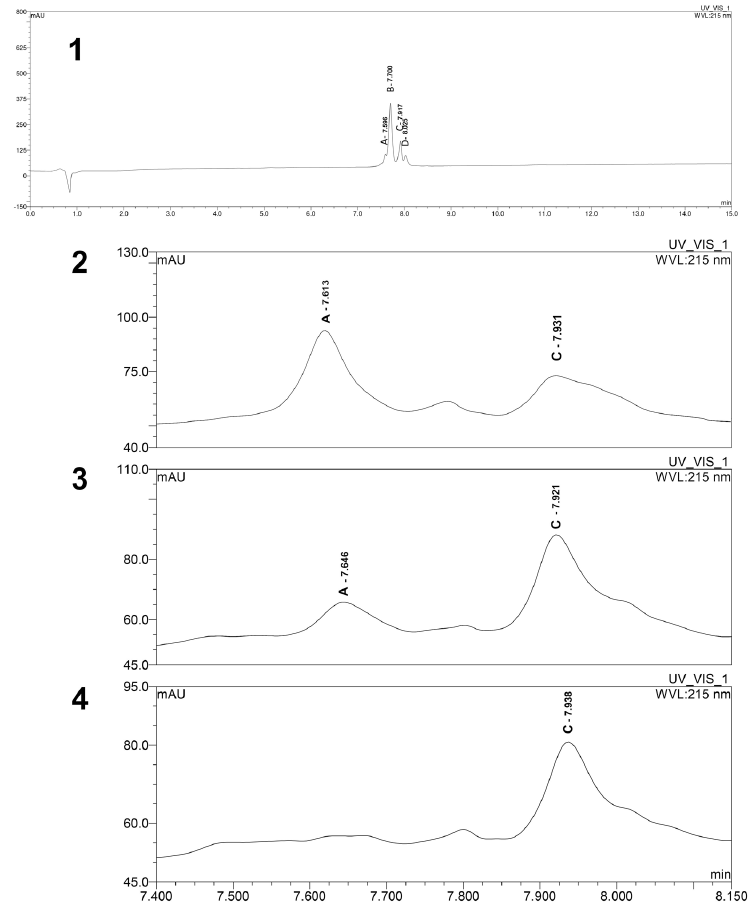
Figure 3. Time course of pRLX simulated digestion. HPLC profile of pRLX at t = 0 min (chromato- graphic conditions reported in the text), showing the four peaks labeled A, B, C, and D (panel ( 1 )). Profile of the relevant peaks after SIF treatment, t = 10” (panel ( 2 )), t = 2 min (panel ( 3 )), and t = 5 min (panel ( 4